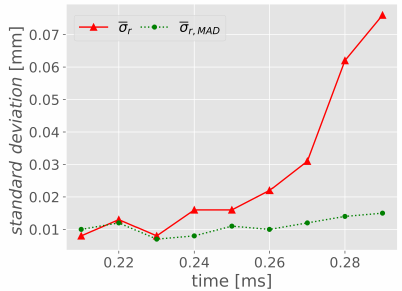
Figure 15. Means of the standard deviations of the crack width areas for each